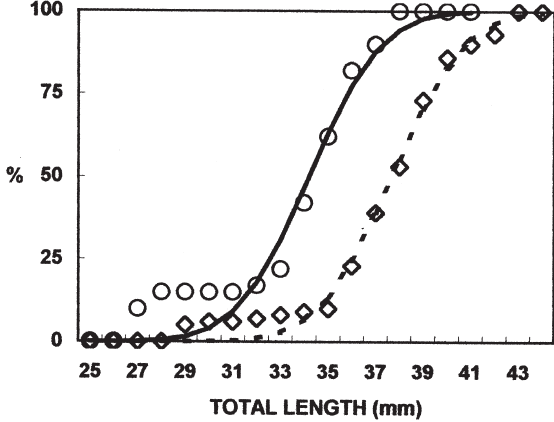
34 mm; striped bars: % of females with TL ≥ 38 mm. T ABLE 3. – Sex ratio of A. minuta during the fishing period (Decem- ber- March) of the years 1985 to 1993; n: individuals number; ** : oocytes per female with an average of 1615 oocytes. The diameter of the oocytes measured in March, ranged between 0.12 and 0.60 mm (average: 0.34 mm, s.d.= 0.12 mm). For each individual there was only one mode in the ovaries indicating that A. min- uta is a single spawner. The number of oocytes from an individual is independent of the fish total length (r 2 = 0.0146), the fish total weight (r 2 = 0.0031) and the gonad weight (r 2 = 0.0418). Therefore, a relationship does not ABLE 4. – A. minuta monthly sex ratio (males:females) from exist between the corporal dimensions of the female December to April during the years 1985 to 1993; * : p< 0.05; ** : p< 0.01. and its fecundity. However, a relationship exist between the size of the gonad (mg) and the diameter of the oocyte (mm) (r 2 = 0.8570). The determined ages were between 63 and 250 days, for a length interval of 14 to 44 mm. The hatch-dates, estimated by means of back-calculation from the reading of daily growth increments in otoliths of A. minuta and the date of capture of the individuals, extended from June to November, with a maximum in October (45% of the hatches) and a second peak in September (20%). A small peak was also observed in July (15%) (Fig. 7).